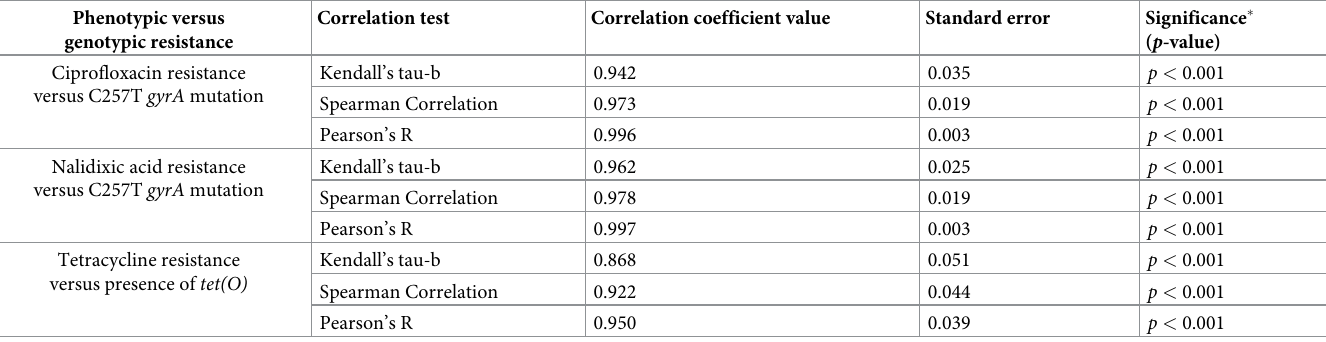
Table 3. Correlation tests between phenotypic and genotypic patterns of clonal complexes’ resistance to ciprofloxacin, nalidixic acid, and tetracycline.